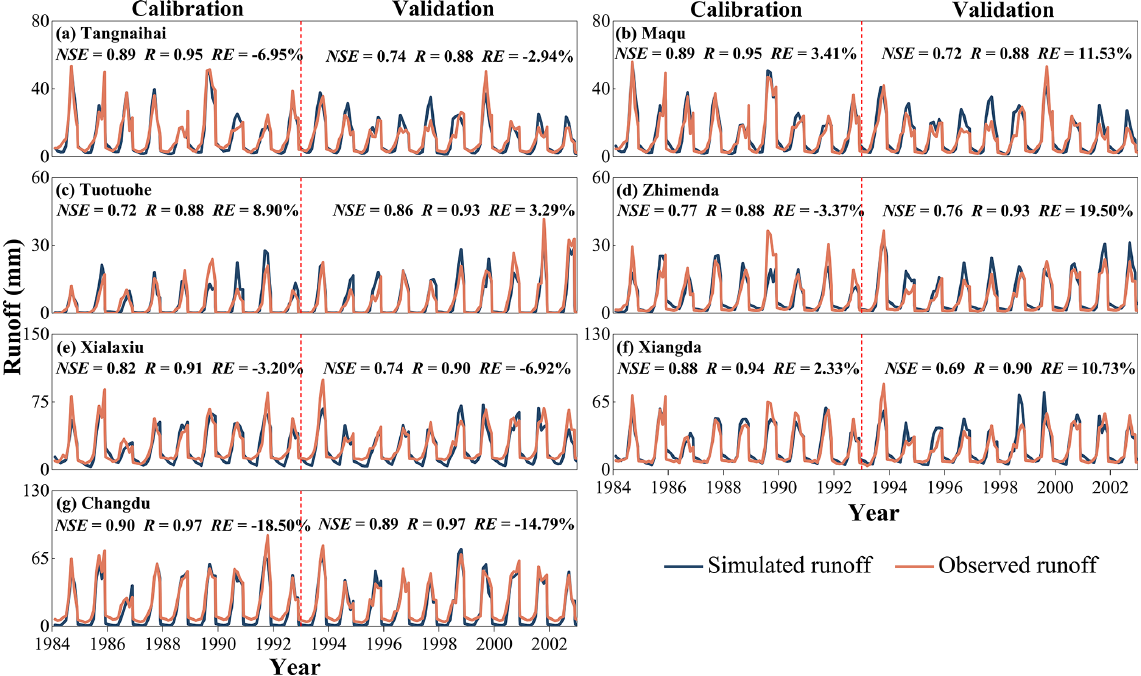
Figure 2. Observed and simulated monthly runoff at the seven stations (a–g) during the calibration period (1984–1993) and validation period